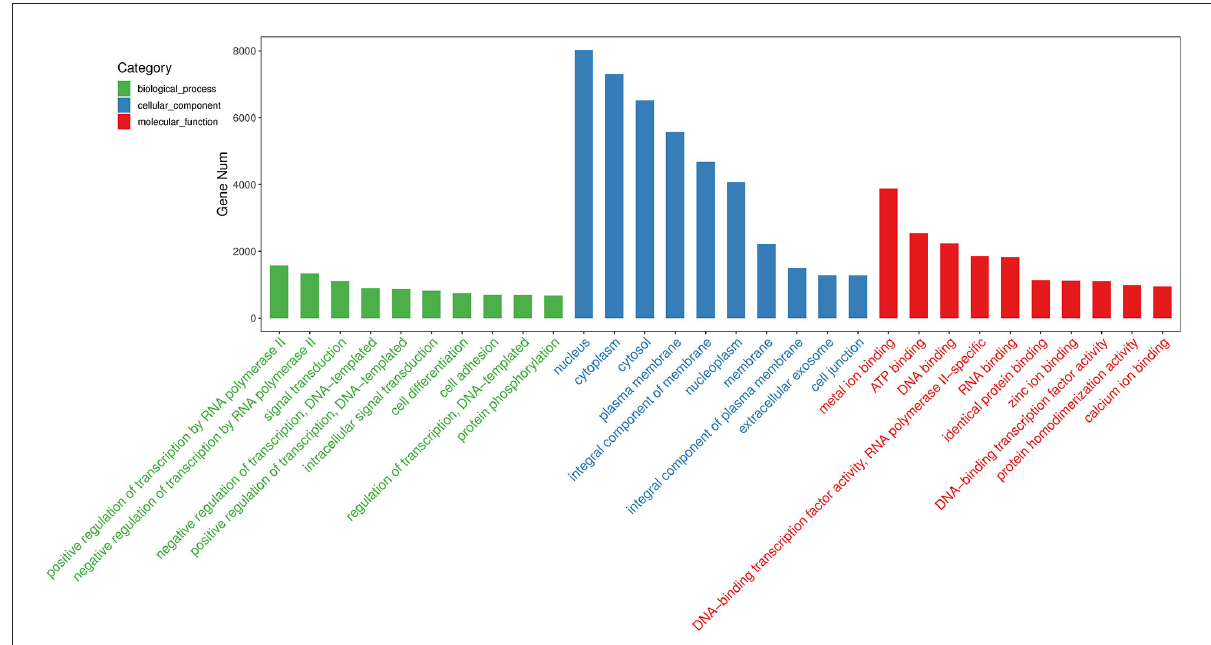
FIGURE3 GO analysis of predicted target genes of differentially expressed miRNAs. Top 10 terms of biological process, cellular component, and molecular function were